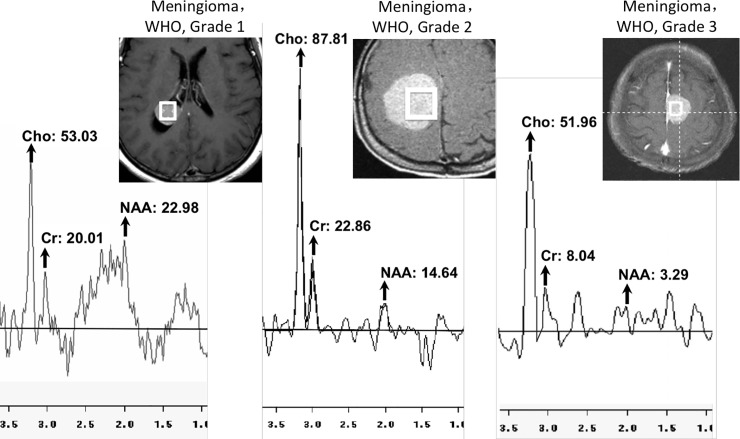
Left, Spectrum of meningioma, WHO, grade 1; Middle, Spectrum of meningioma, WHO, grade 2; Right, Spectrum of meningioma, WHO, grade 3. Cho, choline; Cr, creatine; NAA, N-acetylaspartate.